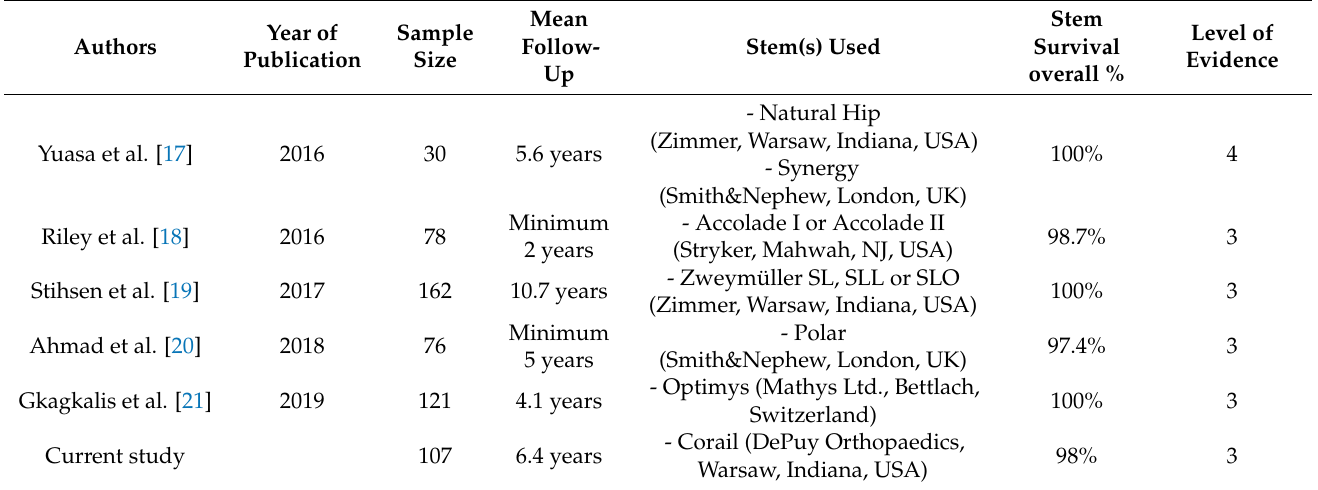
Table 2. Overview of the reported survival rates of uncemented femoral components in patients > 75